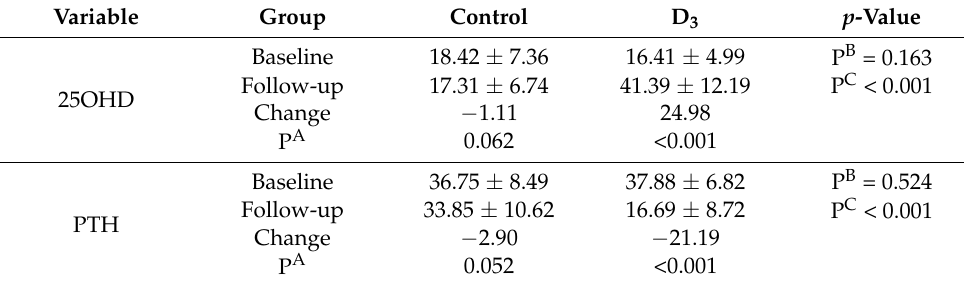
Table 6. Changes in the serum levels of 25OHD and